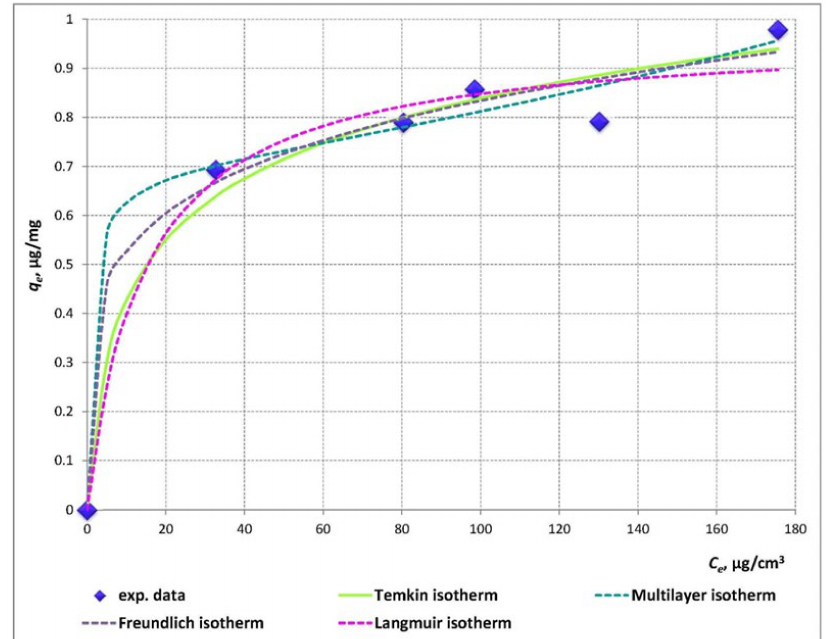
Figure 4. Experimental and model isotherms of catechin microencapsulation into clinosorbent-5 (CLS-5)